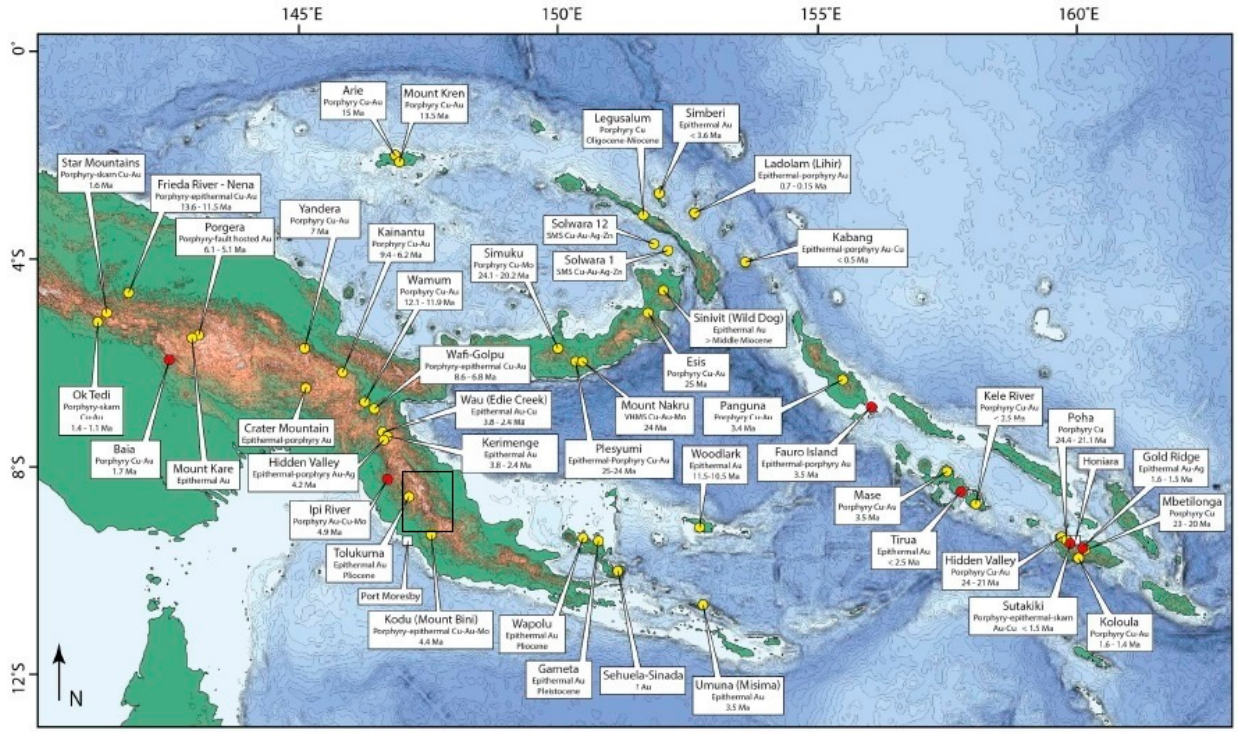
Figure 1. Locations of known porphyry copper deposits and epithermal gold deposits (Holm et al, 2019) with the location of the study area in a dark rectangle. Red marker indicates the location of deposits and prospects where samples have been dated and discussed in Holm et. al., 2019. Yellow markers indicate locations of other known deposits.